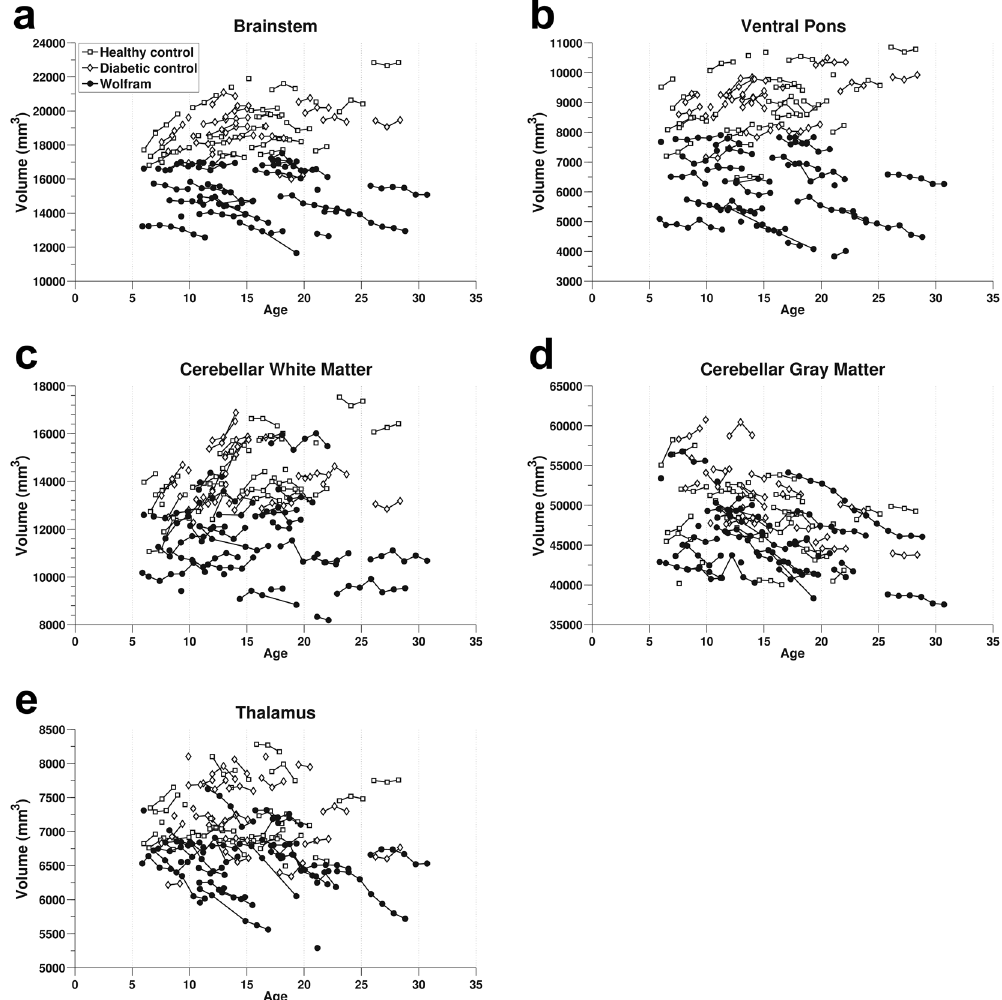
Figure 3. Volumes of regions of interests (corrected for eTIV) over time and age. All regions had a significant interaction of group by time. ( a ) Brainstem, ( b ) Ventral pons, ( c ) Cerebellar white matter, ( d ) Cerebellar gray matter, and ( e ) Thalamus. Freesurfer-derived volume is on the Y-axis and age is on the X-axis. Markers connected by a line denote age at each session for an individual over time. Open markers represent controls while solid markers represent Wolfram